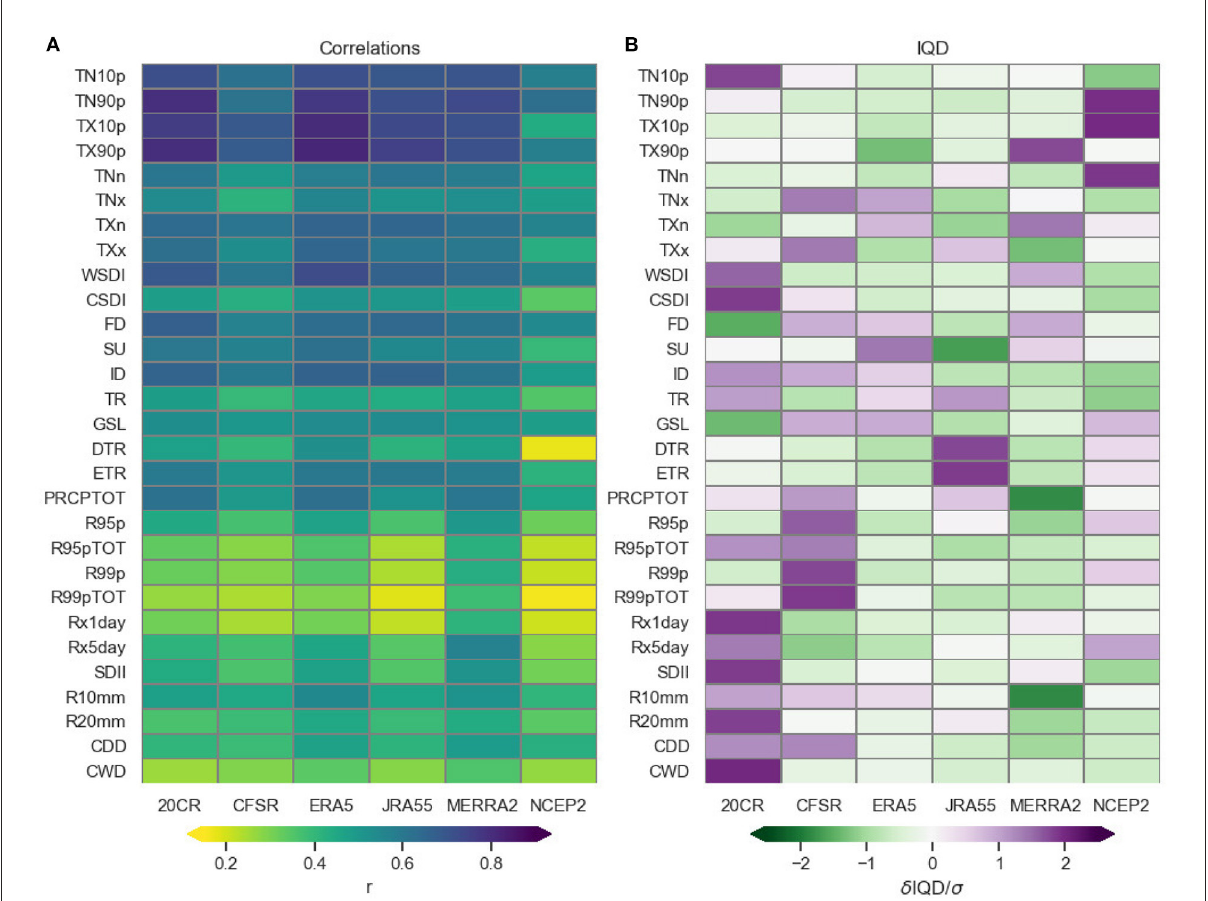
FIGURE11 Summary heatmaps for (A) the globally averaged (cosine-weighted) correlation and (B) normalized IQD values (difference of the IQD from the average across all reanalyses per index, normalized by the standard deviation) calculated against HadEX3. Note the change in color scale used for the correlation panel compared to the maps in other figures. The updated colors were chosen for clarity over the range